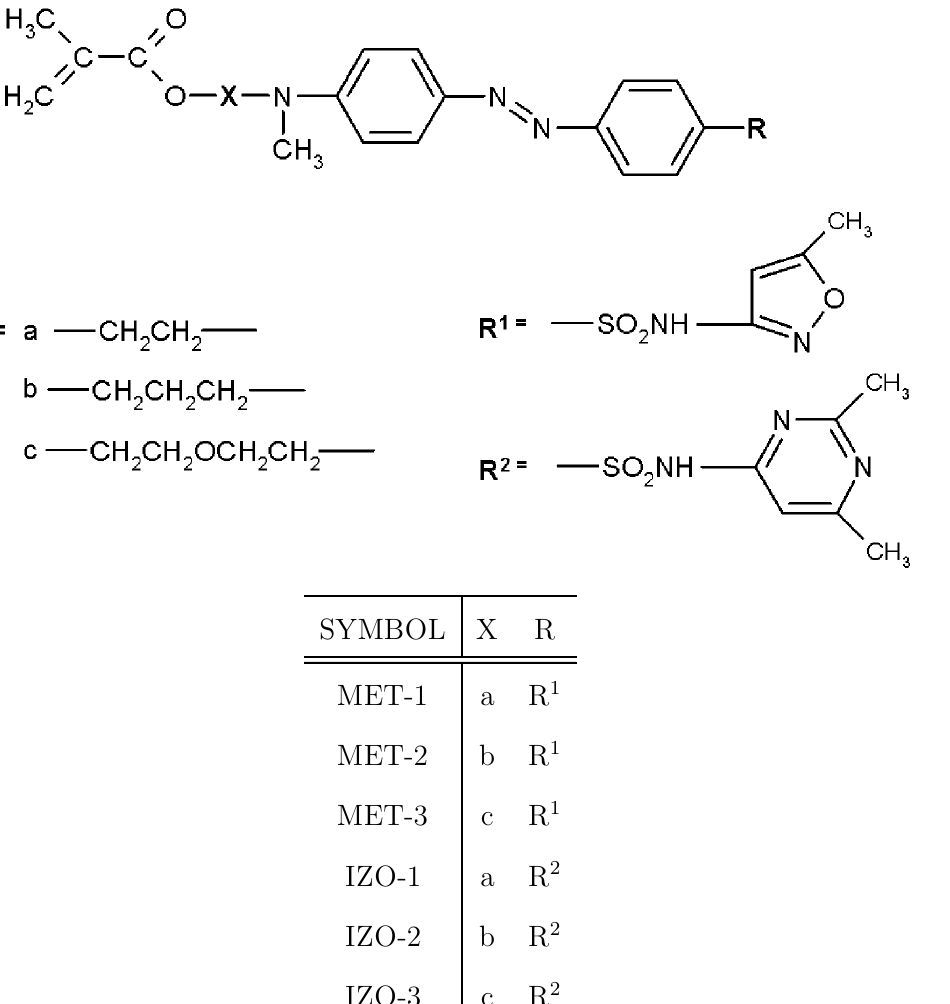
Fig. 1 Structural formulae of the